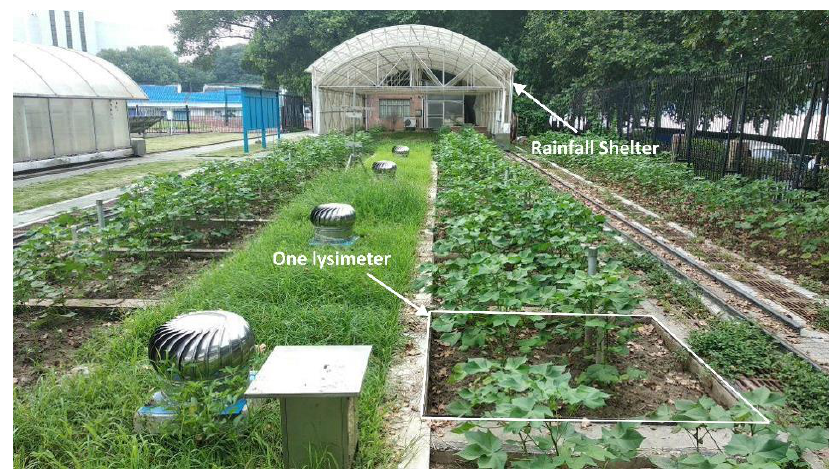
Figure 2. The employed lysimeters and mobile shelters at the experimental site.